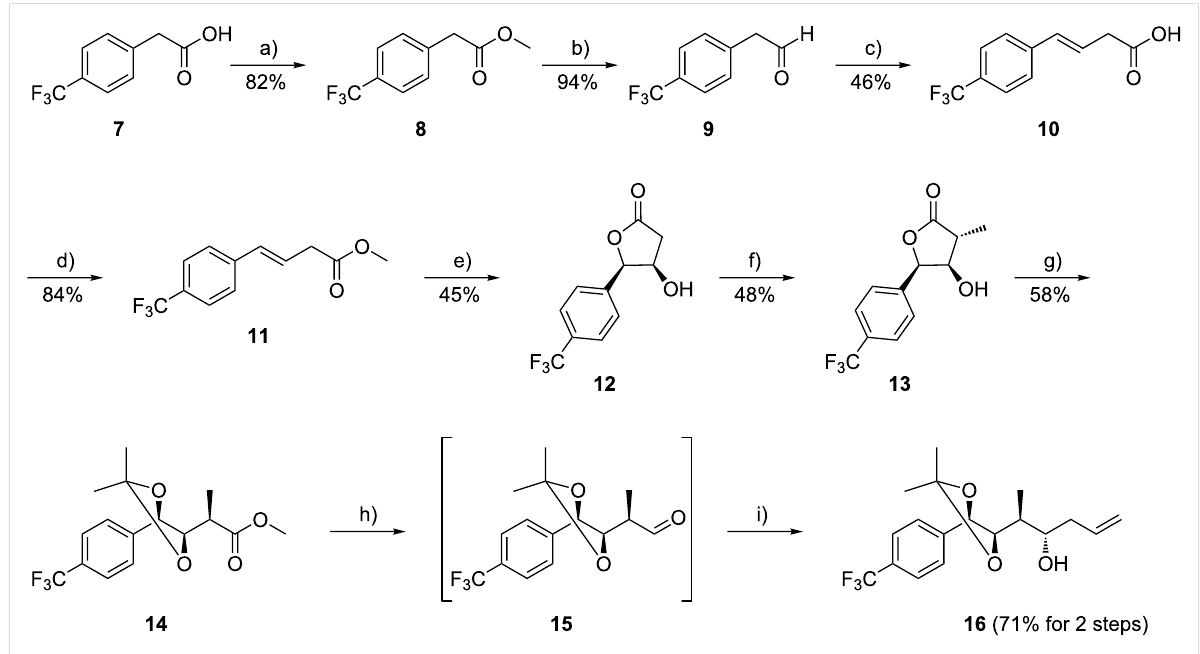
Scheme 1: Access to the trifluoromethyl substituted unit A-building block 16 . Reagents and conditions: (a) SOCl 2 , MeOH, 0 °C → rt, 16 h; (b) DIBAL-H, CH 2 Cl 2 , − 78 °C, 3.5 h; (c) malonic acid, piperidine, AcOH, DMSO, 65 °C, 1.5 h; (d) SOCl 2 , MeOH, 0 °C → rt, 1 h; (e) K 2 CO 3 ,